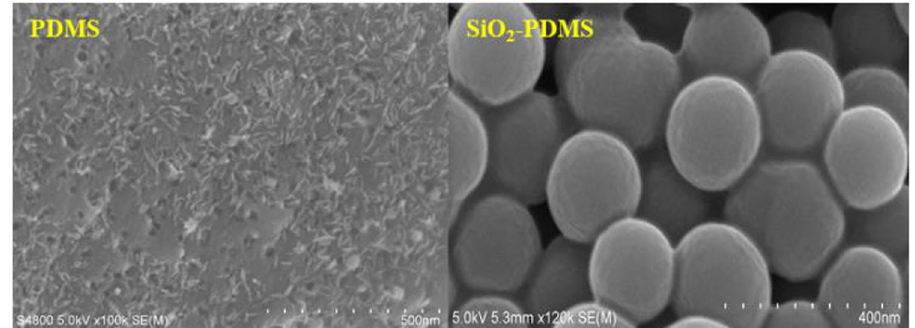
Figure 1. FE-SEM images of PDMS (left) and SiO 2 -PDMS